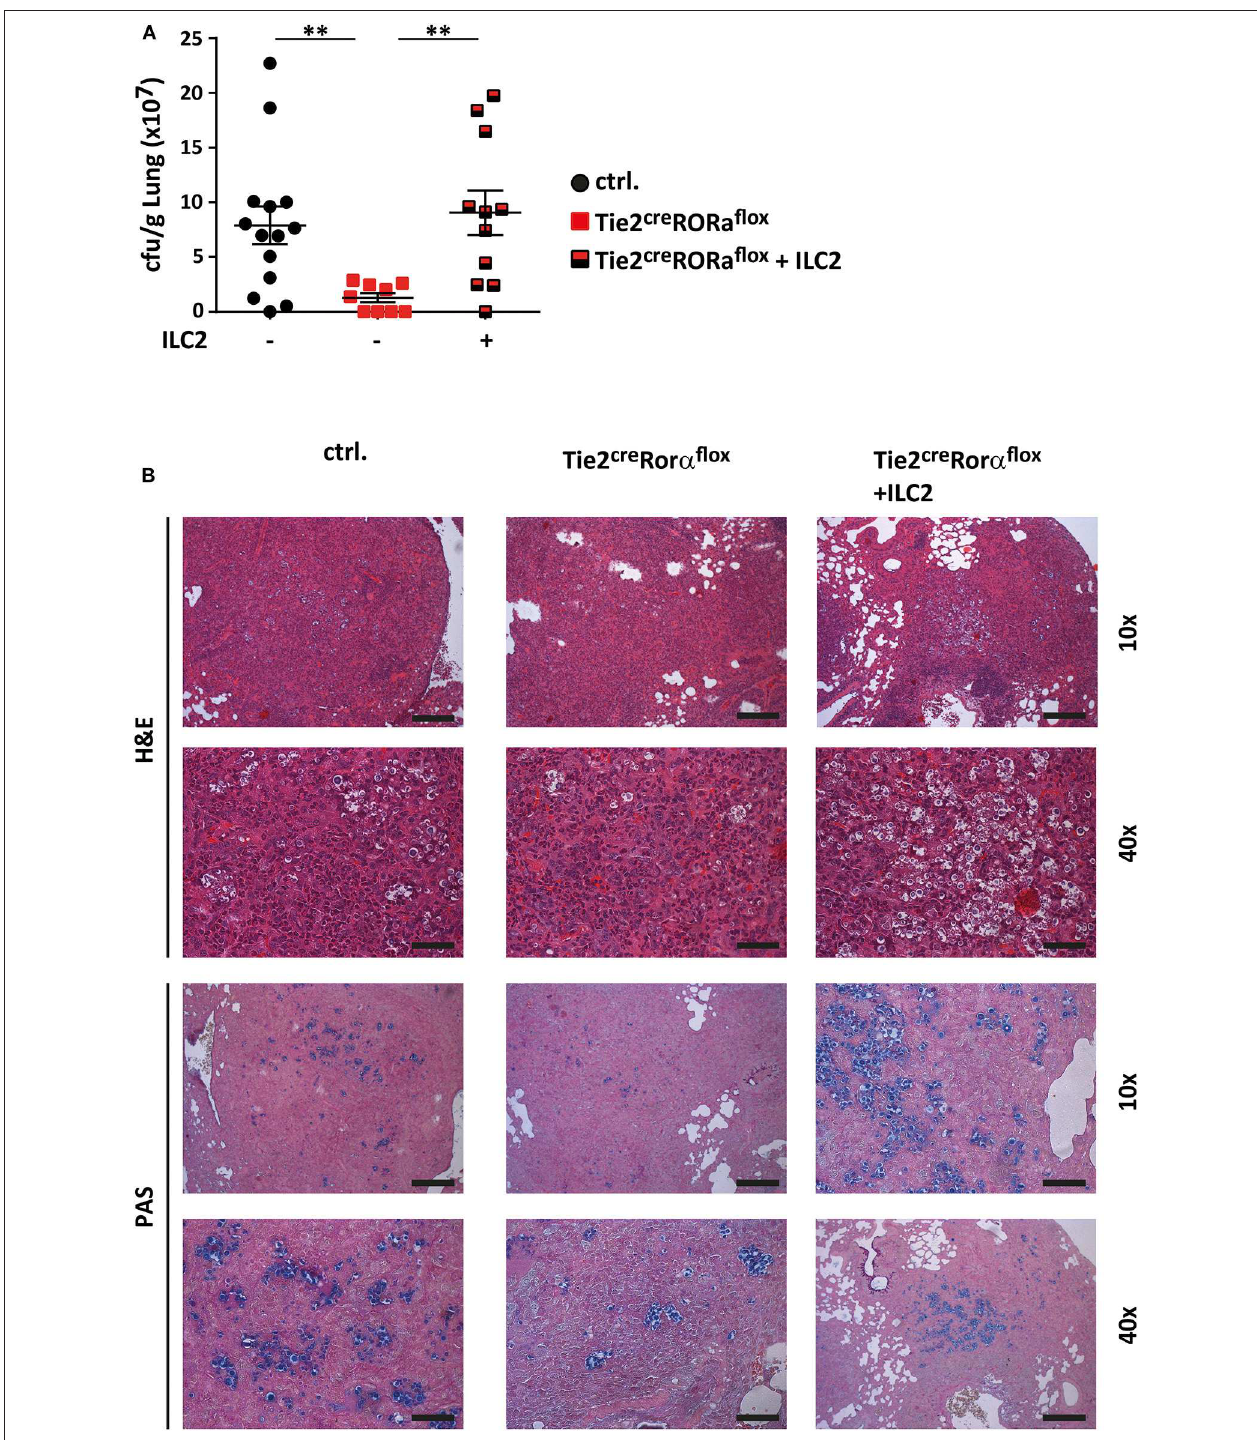
FIGURE 3 | ILC2 drive detrimental anti-cryptococcal immune responses. (A,B) Control and Tie2 cre Rora flox mice were challenged with 500 cfu of C.neoformans. and analyzed 14 dpi. In addition, Tie2 cre Rora flox mice were reconstituted with sort-purified and in vitro expanded ILC2 on day 1 and 7 of infection as described in the method section (Tie2 cre Rora flox + ILC2). (A) Infection loads in affected lungs of ILC2 reconstituted Tie2 cre Rora flox mice ( n = 11) were quantified and compared to control. ( n = 14) and Tie2 cre Rora flox mice ( n = 9). (B) Representative H&E and PAS stainings of control, Tie2 cre Rora flox and ILC2 reconstituted Tie2 cre Rora flox mice. Scale bar 10 × magnification = 200 µ m, scale bar 40 × magnification = 50 µ m. Data is expressed as mean ± SEM, and pooled from (A) three independent experiments ** P ≤ 0.01 using a Mann-Whitney U -test.